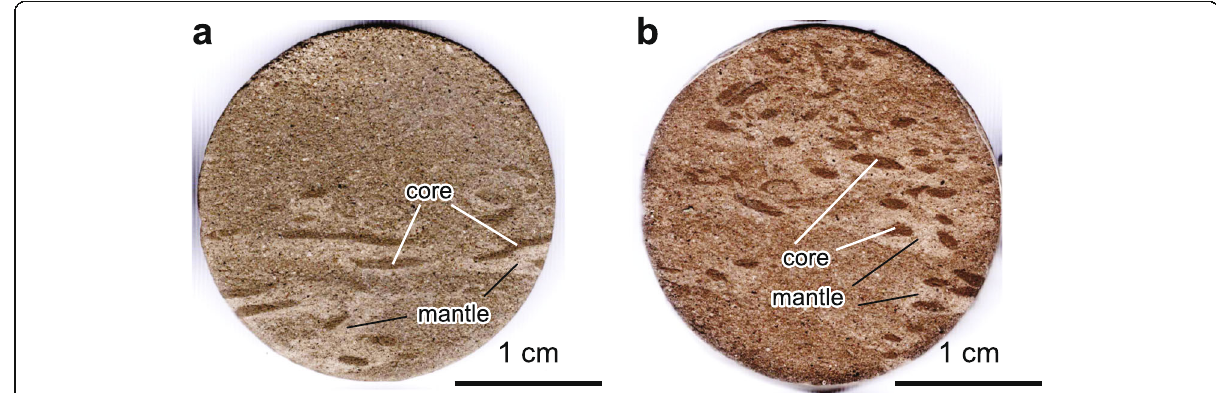
Fig. 4 Scan images of the selected samples of the polished paleomagnetic core. a Sample ID: TB3-37. b Sample ID: TB3-53. The paleomagnetic cores were cut perpendicular to bedding planes, thus, the upward direction of these images represent stratigraphically higher direction. Note abundant Phycosiphon in the surface. In addition, the core and mantle of Phycosiphon can clearly be